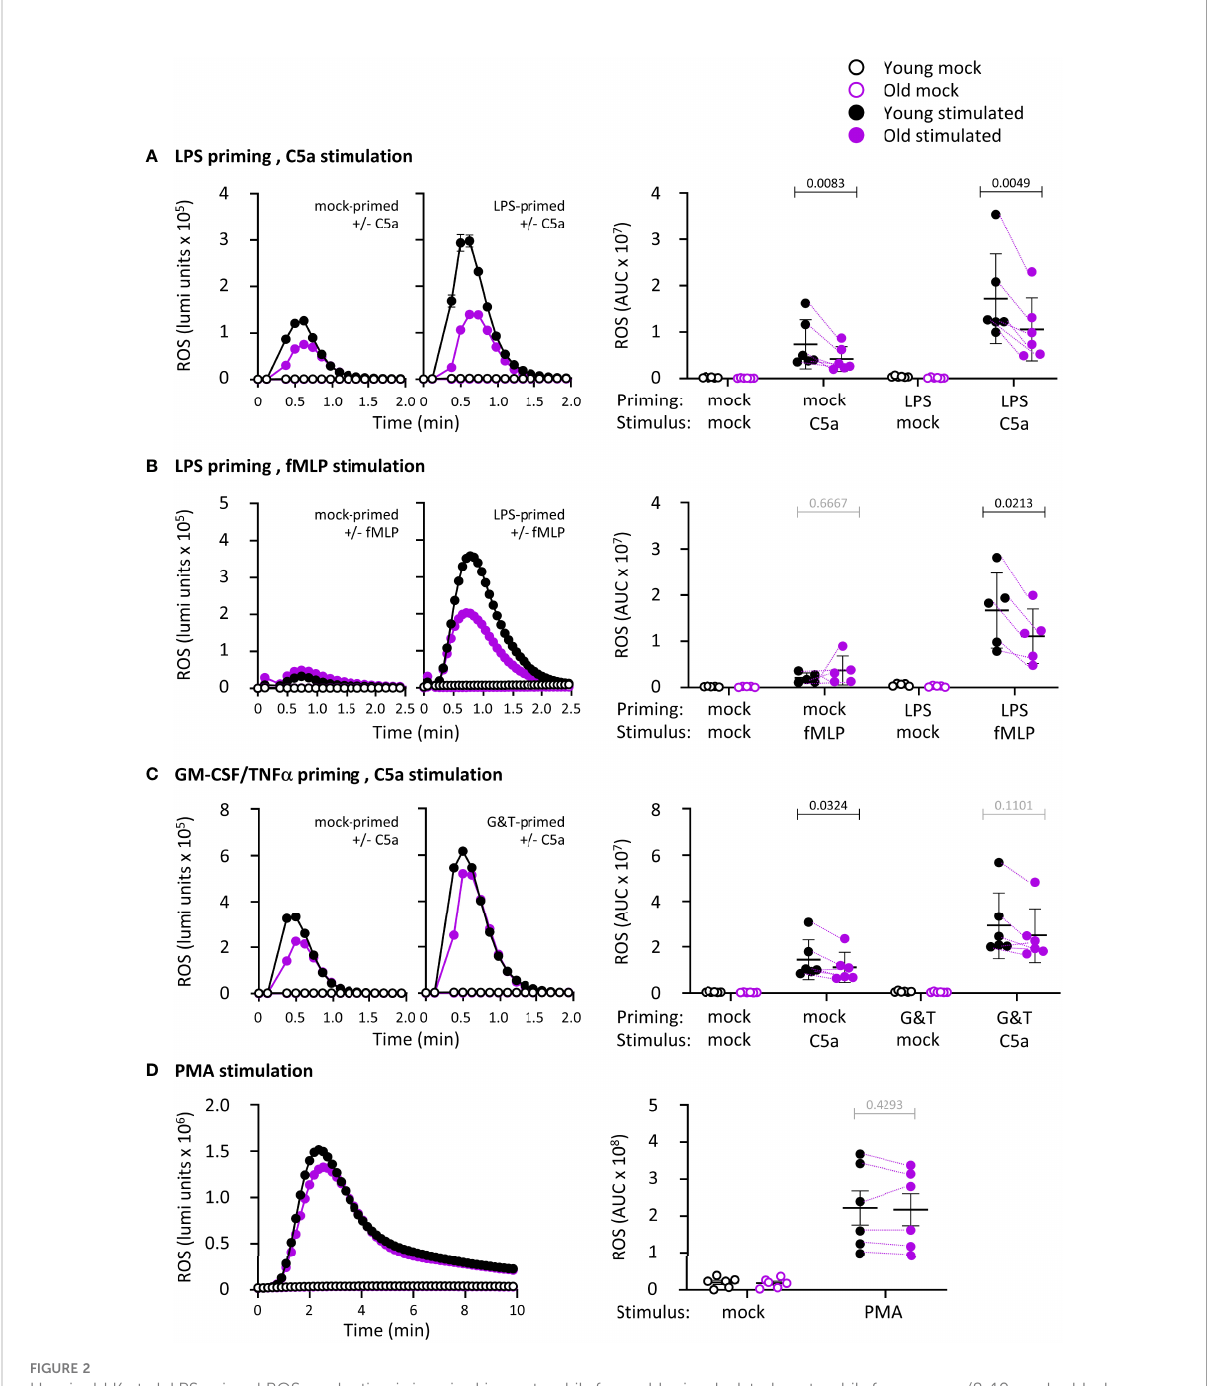
FIGURE 2 Hornigold K et al. LPS-primed ROS production is impaired in neutrophils from old mice. Isolated neutrophils from young (8-10 weeks, black symbols) and old (24 months, purple symbols) mice were primed with (A, B) 1 m g/ml LPS for 90 min or with (C) 100 ng/ml GM-CSF and 5 ng/ml TNF a for 45 min, or were mock-primed for the same periods of time, or (D) kept unprimed, prior to stimulation with (A-C) 25 nM C5a, (B) 3 m M fMLP or (D) 500 nM PMA (closed symbols), or mock-stimulation (open symbols), as indicated. ROS production was measured by real-time chemiluminescence assay with luminol and HRP for extra- and intracellular ROS. Left-hand panels show representative luminometer traces from one experiment; right-hand panels show the quanti fi cation as AUC. Data are mean ± SEM of 5-6 independent experiments, as indicated; each dot is the mean AUC from one experiment. Matched data are indicated by purple lines for stimulated cells. Statistics are two-way ANOVA with Sidak ’ s multiple comparisons tests on log-transformed raw data, in A-C for chemoattractant-stimulated cells; black p-values are signi fi cant, grey p-values non-signi fi